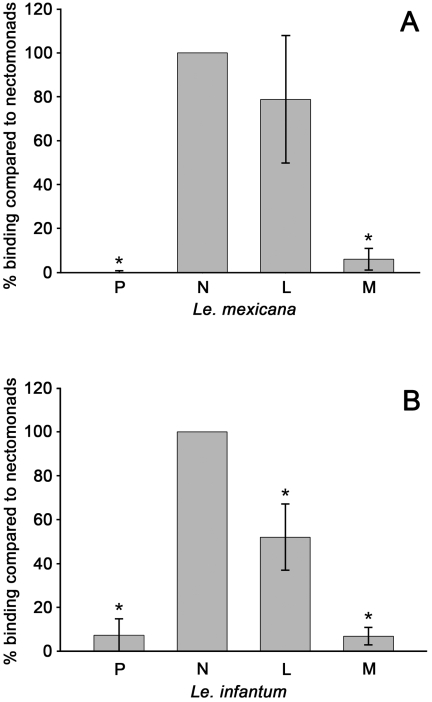
Comparative binding of enriched parasite populations to Lu. longipalpis midguts.All populations were compared to the binding of the nectomonad-enriched culture. (A) L. mexicana (11 experiments) (B) L. infantum (5 experiments). Cultures were enriched for: procyclic promastigotes (P); nectomonad promastigotes (N); leptomonad promastigotes (L) and metacyclic promastigotes (M). Each bar represents the mean percentage ± S.D. and the asterisks indicate a significant difference to the nectomonad population (>20 dissected guts examined per experiment).